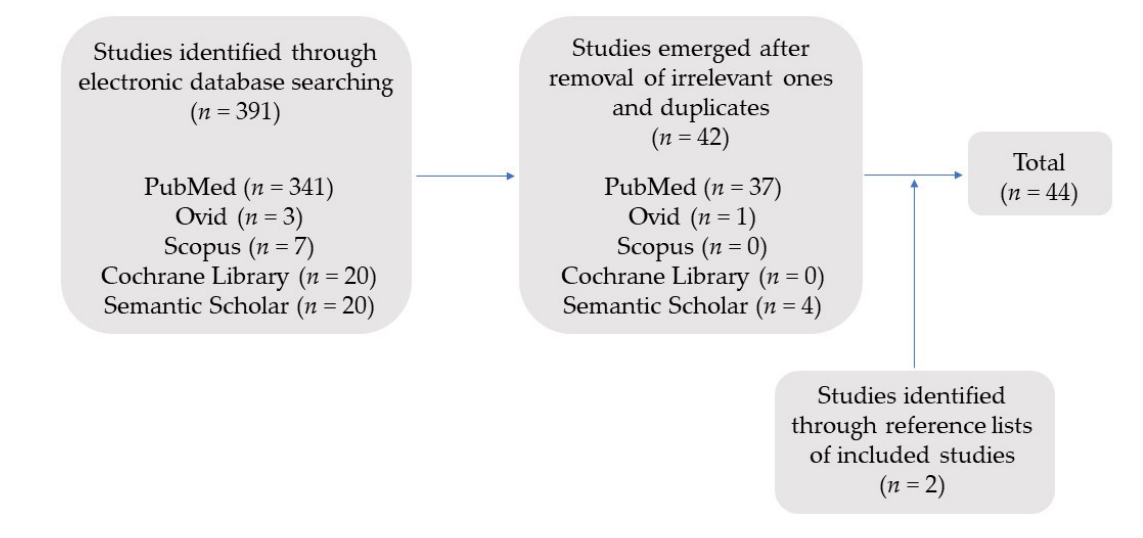
Figure 1. Process of final studies selection. Table 1. Characteristics of the included studies .